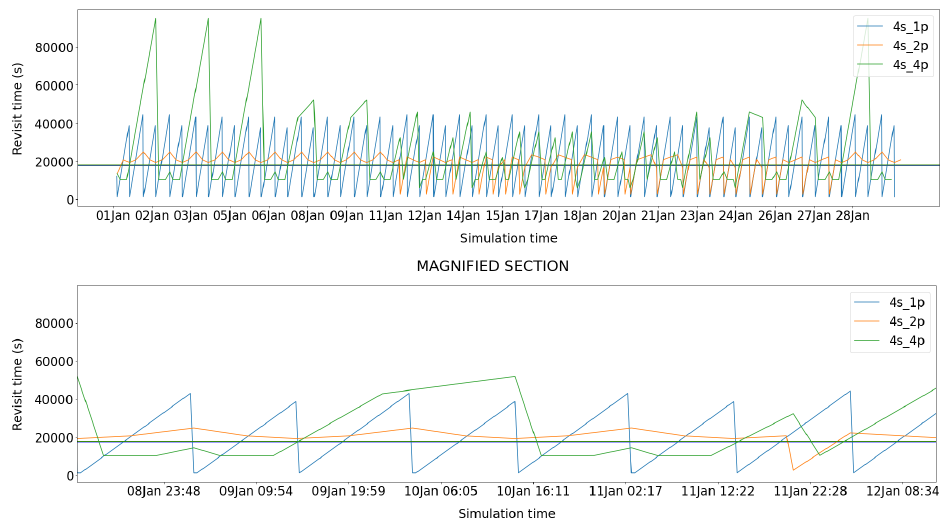
Figure 13. Simulated revisit times over an atmospheric region above mid-latitudes: 1-month simula- tion (above); zoom covering a few days